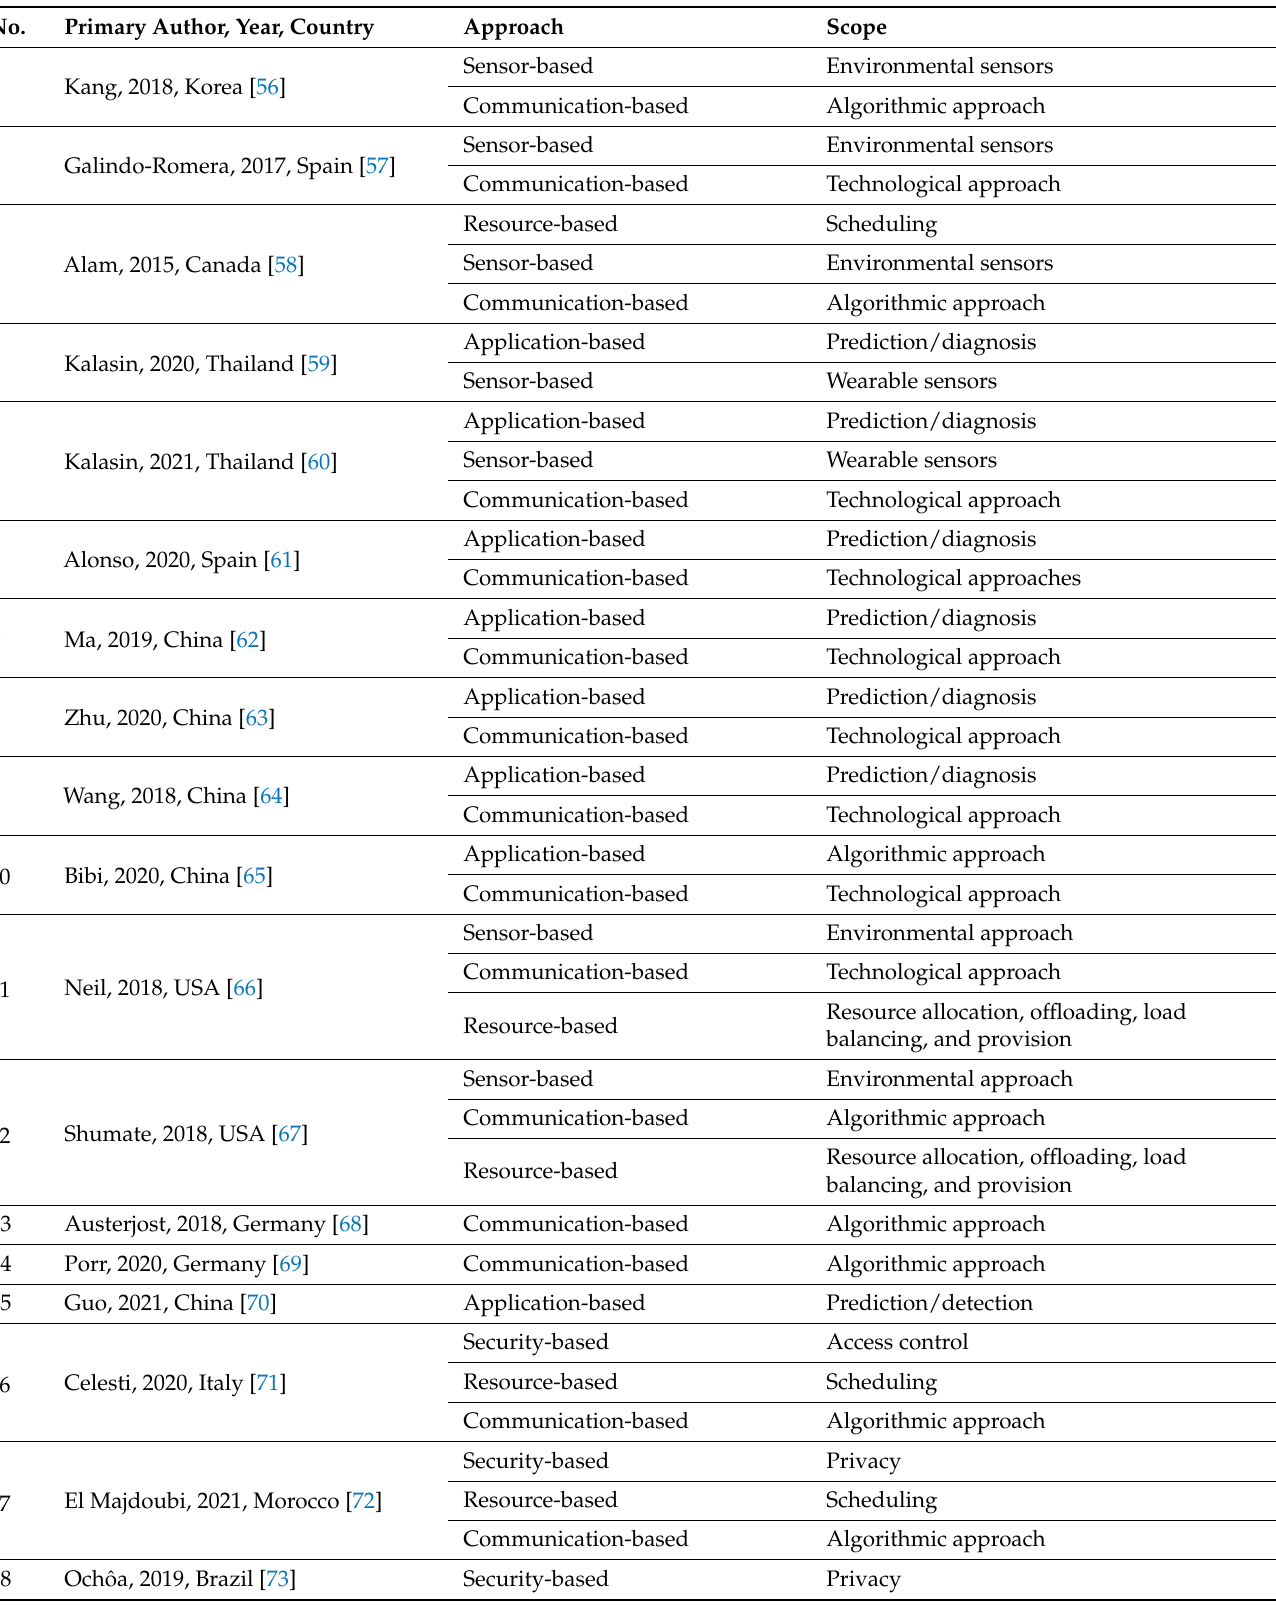
Table 4. Summary of the approaches and scopes of the included studies, based on key approaches summarized in Section